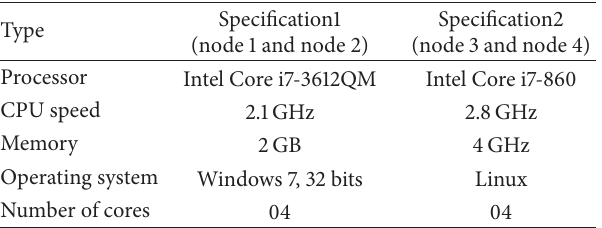
Table 1: Hardware